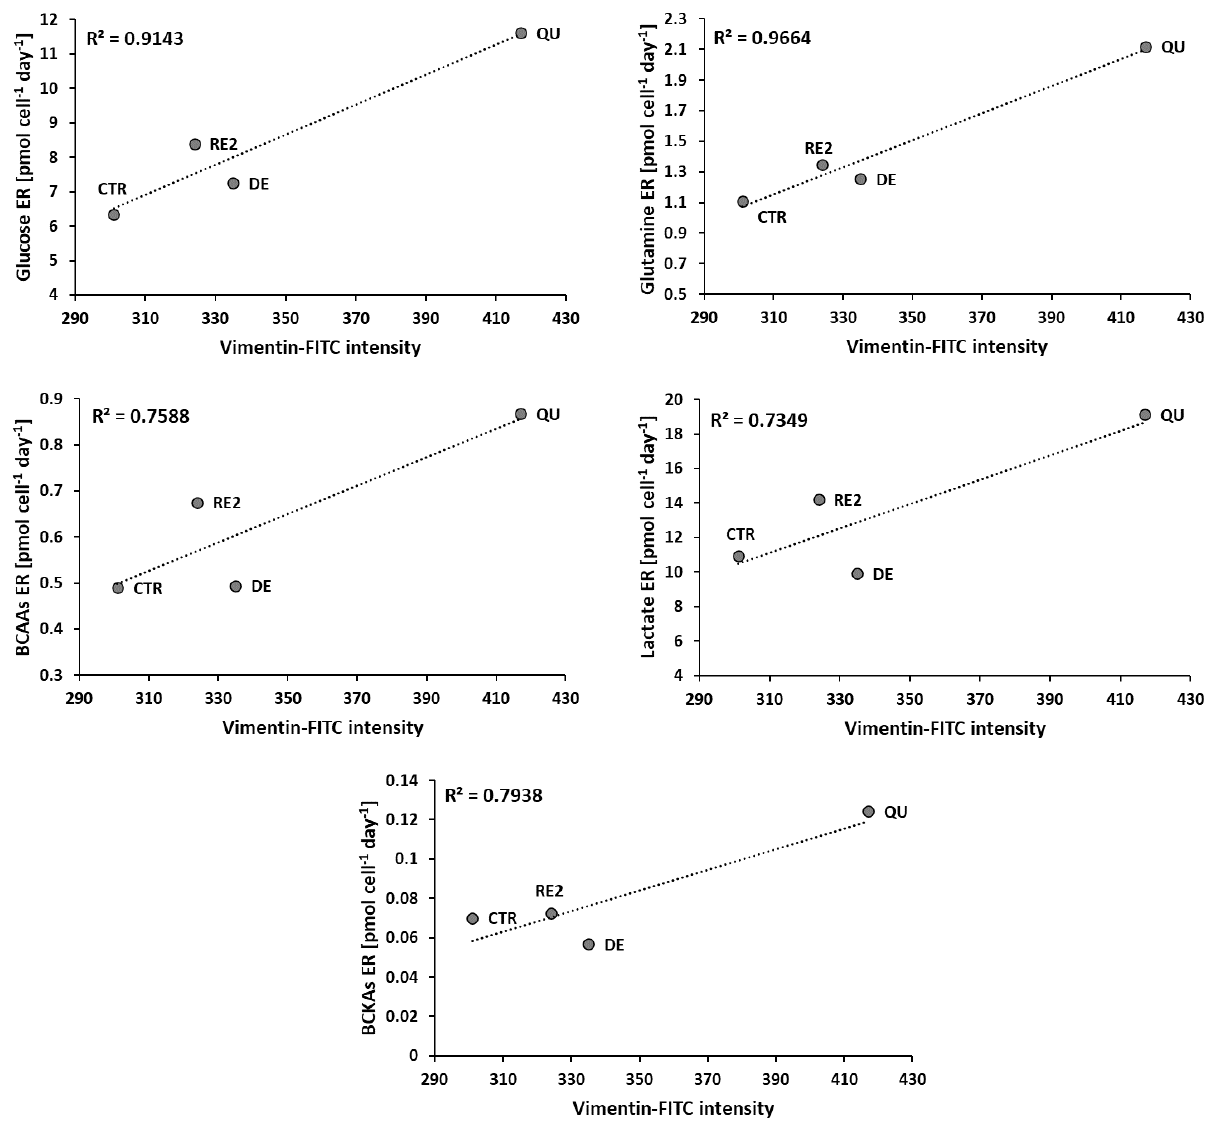
Figure 7. Vimentin expression after CTR, DE, QU, and RE2 phases vs. the ERs of the principal nutrients (glucose, glutamine, and BCAAs) and main excreted metabolites (lactate and